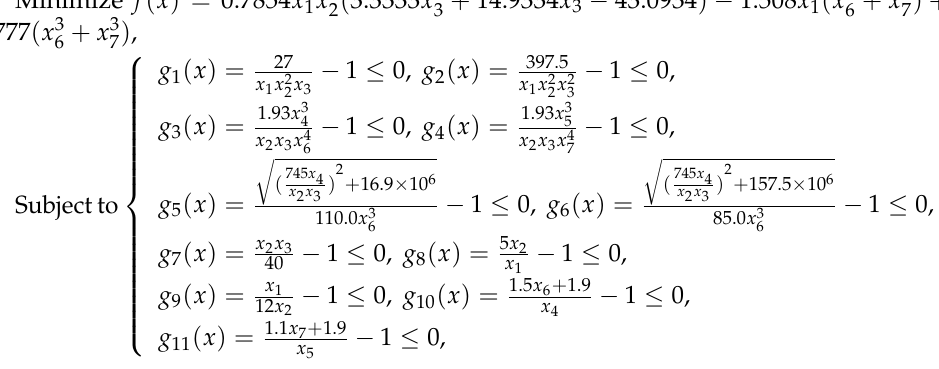
and other comparison algorithms as listed in Table 8. As can be seen from this table, the